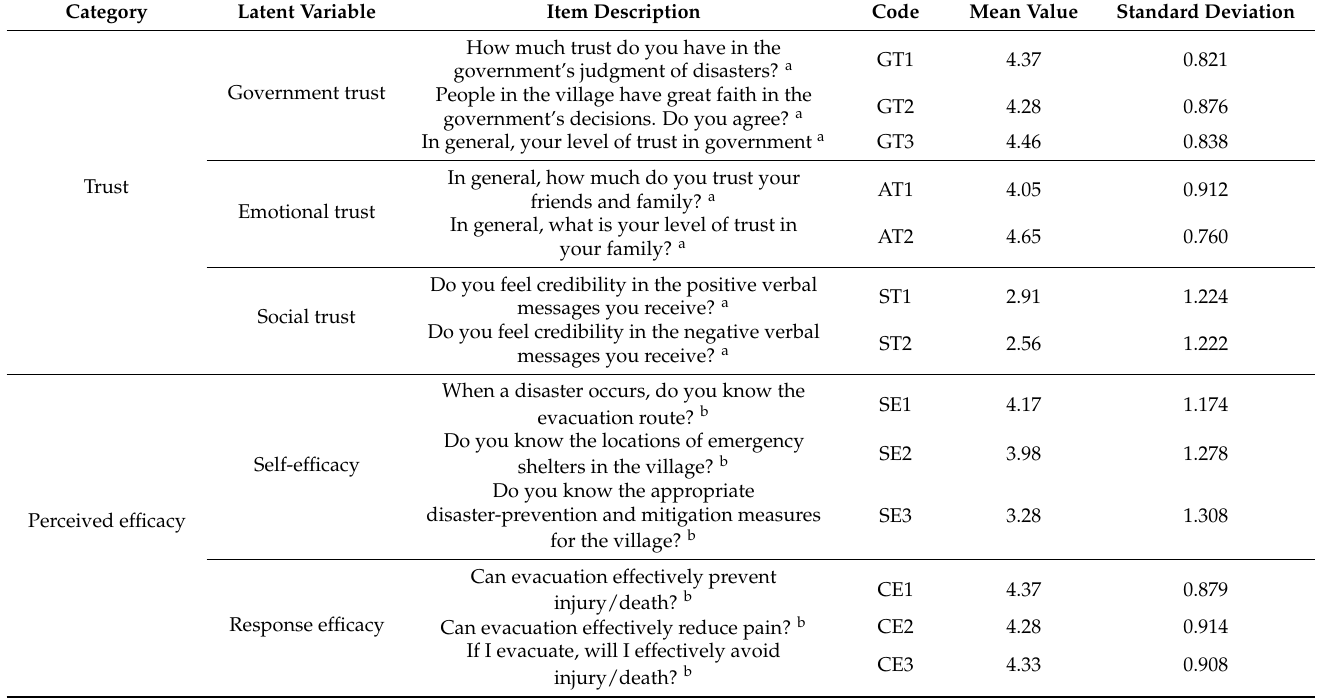
Table 2. Definition and descriptive statistics of the variables in the